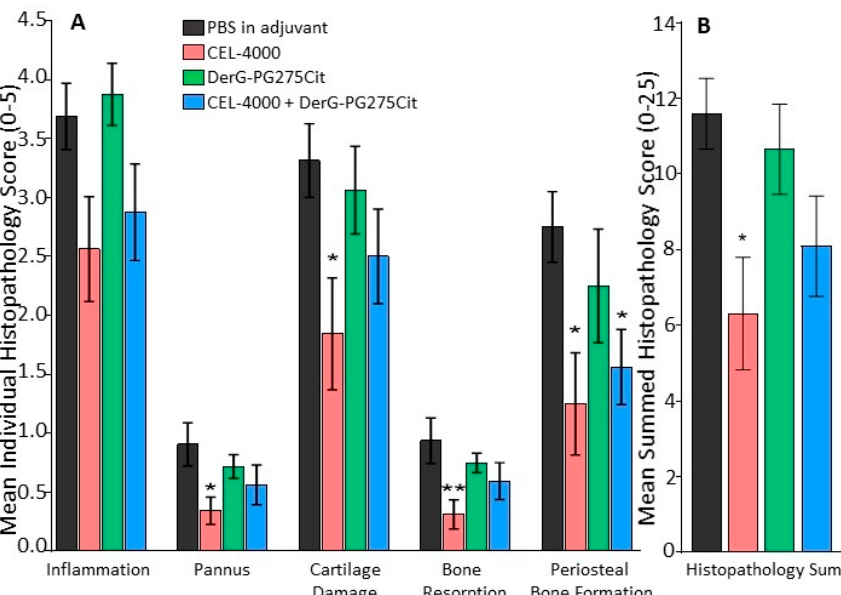
Figure 5. Analyses of histopathological data. Images of the joint sections of control and LEAPS treated GIA mice (from study 2) were examined and scored by an independent team of certified pathologists. TB- and H&E-stained sections of hind limbs from coded GIA mice ( n = 8 per group) were photographed and scored for the degree of ( A ) inflammation, pannus formation, cartilage damage, bone resorption, and periosteal bone formation. Each of these parameters received a score ranging from 0 to 5. Hind limbs from naïve (non-immunized) female BALB/c mice were also processed for histology for reference to normal joint structure (scored as 0). ( B ) Summed histopathological scores were calculated from the above-listed individual scores. The results are in agreement with prior reports for CEL-4000-treated and control animals as well as with the in vivo findings shown in Figure 4. The non-parametric Kruskal–Wallis test, one-Way ANOVA, and Dunn’s multiple comparison test were used for statistical analysis (* p ≤ 0.05, ** p ≤ 0.01). Representative TB-stained joint section images from each group of control and LEAPS vaccinated GIA mice are shown in Supplementary Figure